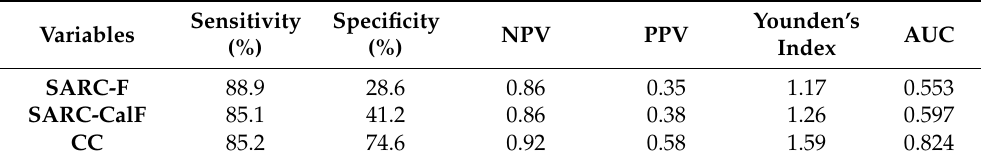
Table 6. Performance of screening tools (SARC-F and SARC-CalF) and CC in the detection of sarcopenia